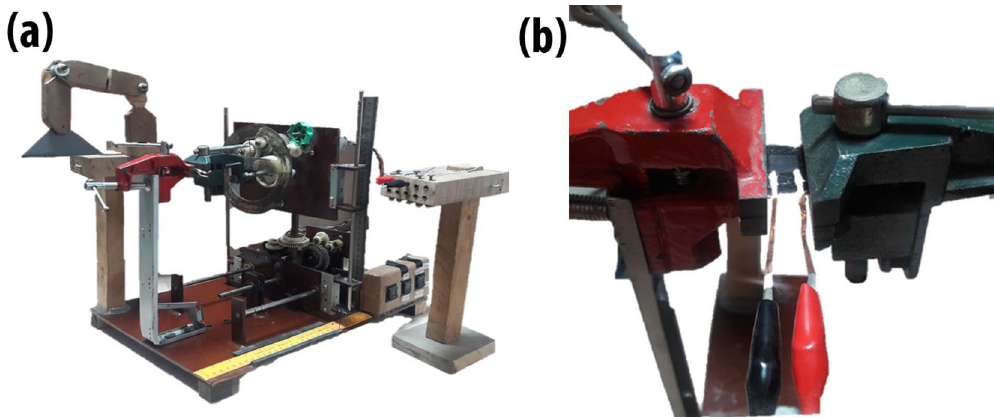
Figure 2. ( a ) Locally developed electrically actuated testing rig is proficient for applying five types of strain for thin films. It works for stretching, compression, bending (upside, downwards), and torsion (clockwise, anti- clockwise). ( b ) The clamp structure contains jaws to hold the sensor in place and to apply strain. One of the jaws is fixed, while the other is electrically